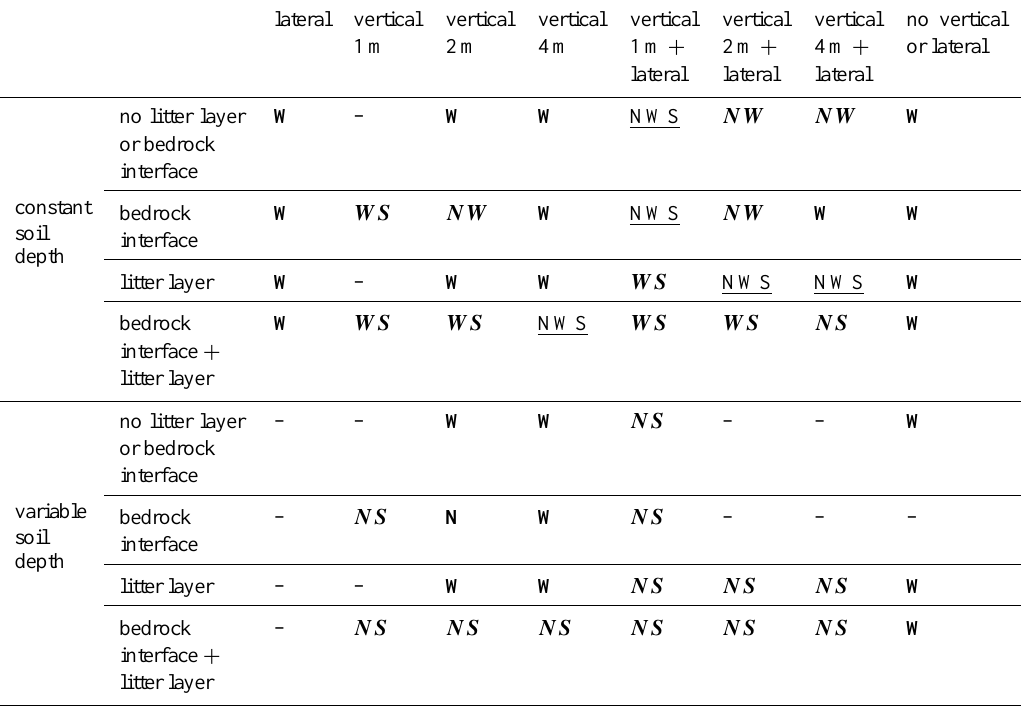
Table 3. Results of the water transport simulations of the 64 basic set-up variants in relation to the three model evaluation criteria (“N”: NSE greater than 0.75; “W”: water balance error less than 10 %; “S”: surface runoff during the sprinkling phase less than 10% of total outflow); letters indicate which criteria were fulfilled, and text in bold, bold+italic, and underlined indicate how many criteria were fulfilled.